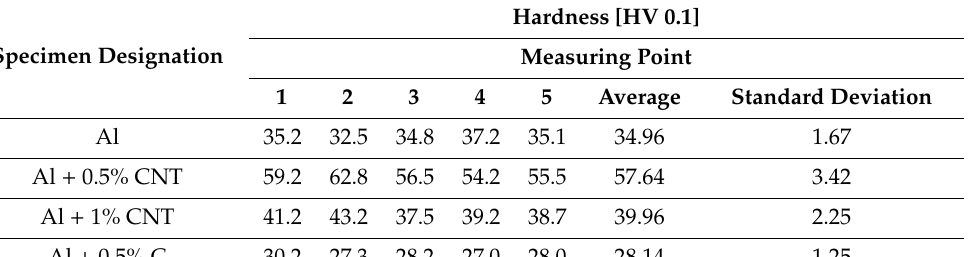
Table 4. Surface hardness results of the flame-sprayed aluminum and aluminum reinforced with carbon material coatings.